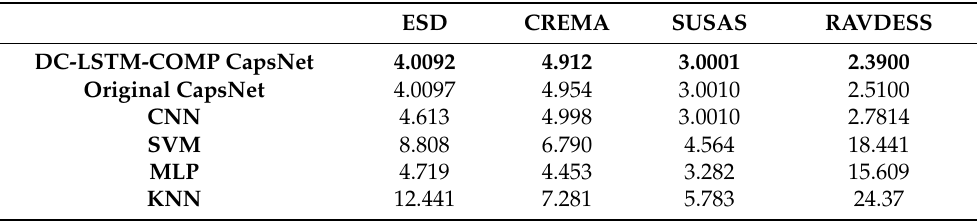
Table 11. Testing times (in seconds) of speaker verification of the different classifiers using ESD, CREMA, SUSAS, and